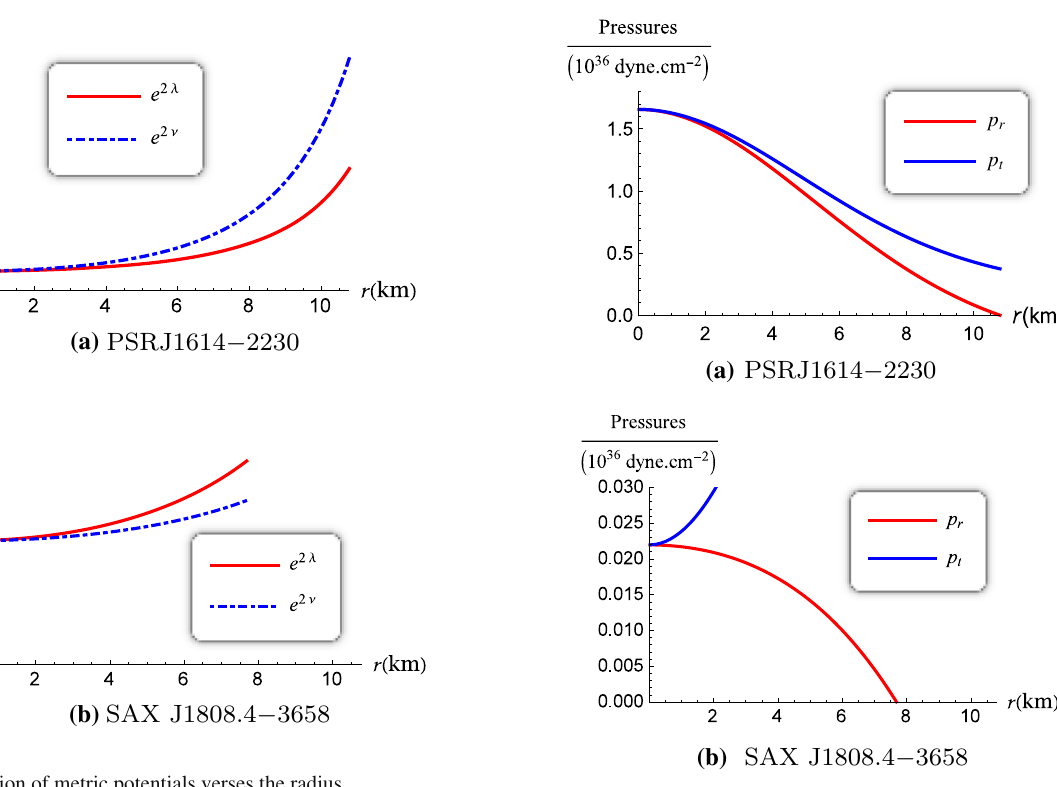
Fig. 1 Variation of metric potentials verses the radius